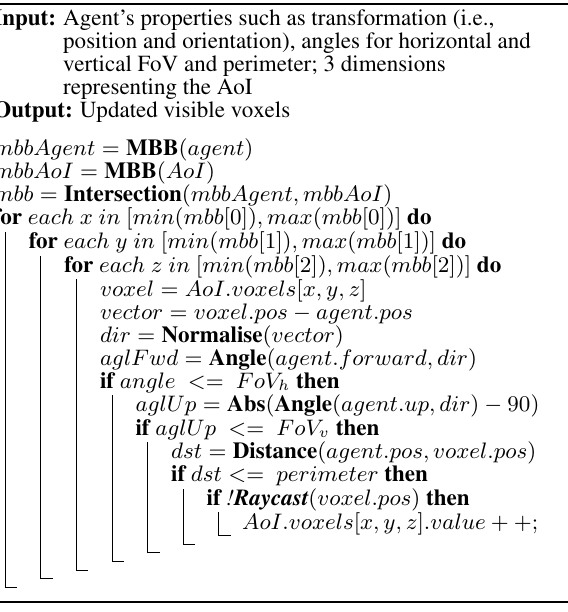
Algorithm 1: The process of identifying and updating visible